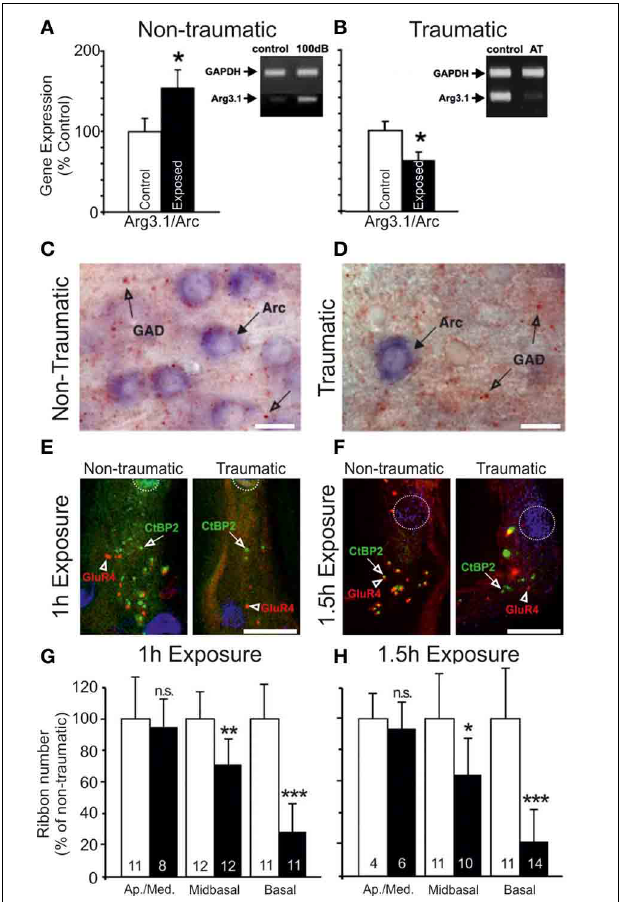
FIGURE 2 | ChangesintheauditorycortexexpressionofArg3.1/Arcand cochlearribbonsynapsedensityrelatedtothedegreeofacoustictrauma. (A) Following exposure to acoustic trauma that renders non-permanent thresholdelevation(100dBSPL,2h),reverse-transcriptasepolymerasechain reaction (RT-PCR) analysis reveals Arg3.1/Arc expression is significantly upregulated in the auditory cortex; (B) by contrast, animals overexposed at 115–119dB SPL for 2h displayed marked downregulation of Arg3.1/Arc transcipts. Modified with permission from Tan et al. (2007). ∗ p ≤ 0 . 05. (C,D) Thisrelativedownregulationisillustratedbyimmunohistochemicallabelingof Arg3.1/Arc mRNA in the auditory cortex of animals exposed to a similar trauma(120dBSPL,2h).Glutamatedecarboxylasepunctaarealsoindicated. Modified with permission from Singer et al. (2013). When animals were acoustically overexposed for either (E) 1h or (F) 1.5h, staining in the cochlea for IHC ribbon synapses (CtBP2, green, open arrows) indicated a subset of animals with marked reduction in ribbon synapse density, illustrated here for the mid-basal turn of the cochlea. IHC nuclei are labeled with DAPI (blue, circled); glutamate receptor subunit GluR4 protein labeled (red, open arrowheads).Scalebars10 μ m. (G,H) Foreachexposureprotocol,asubsetof animals could be categorized according to significant proportional reductions in midbasal and basal cochlear IHC ribbon synapse densities, relative to exposed animals without this pathology. Open bars = controls; filled bars = exposed. Numbers in each bar correspond to respective n . Modified with permission from Rüttiger et al. (2013). ∗ p ≤ 0 . 05; ∗∗ p ≤ 0 . 01; ∗∗∗ p ≤ 0 .